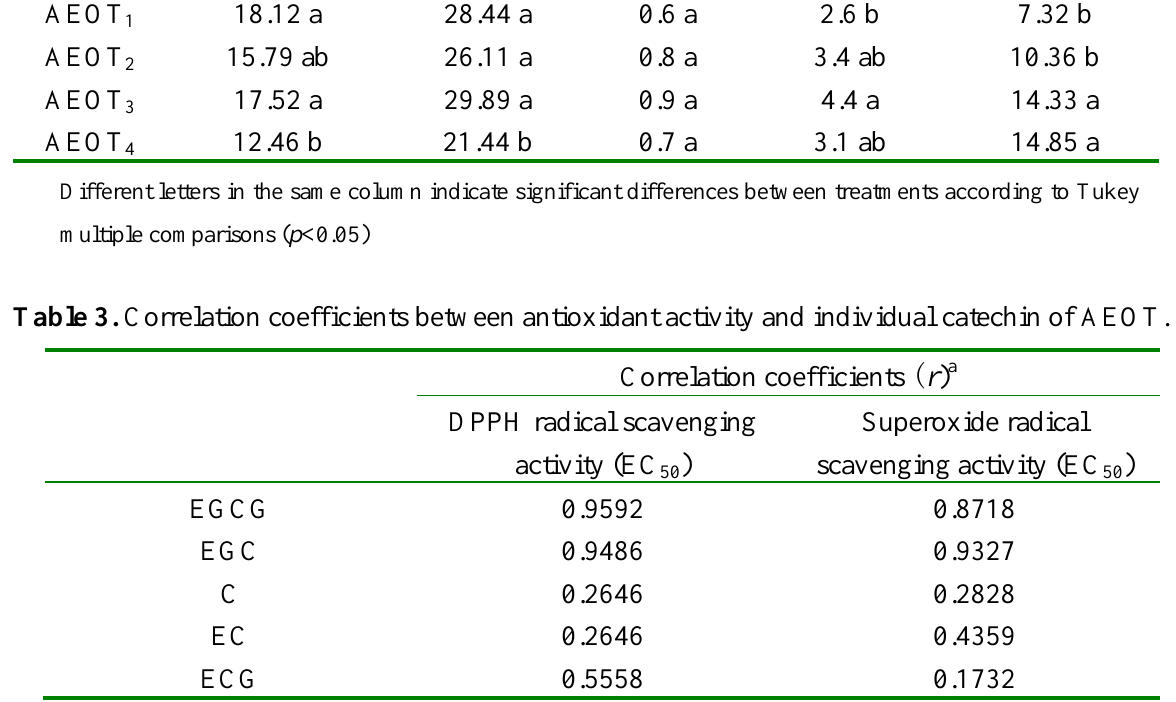
Table 2. Catechin contents in AEOT under various steeping conditions (expressed as mg/100mL). Sample